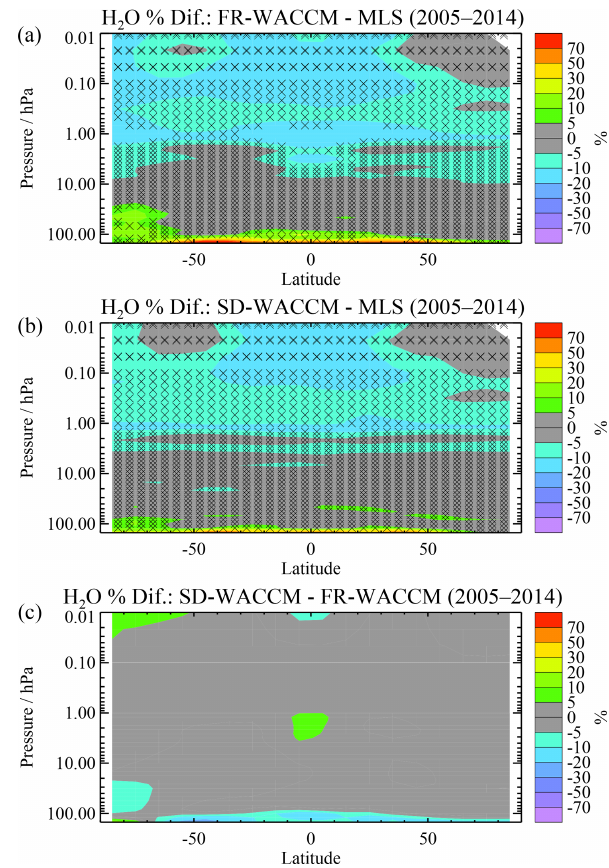
Figure 3. Same as Fig. 1 but for stratospheric and mesospheric wa- ter